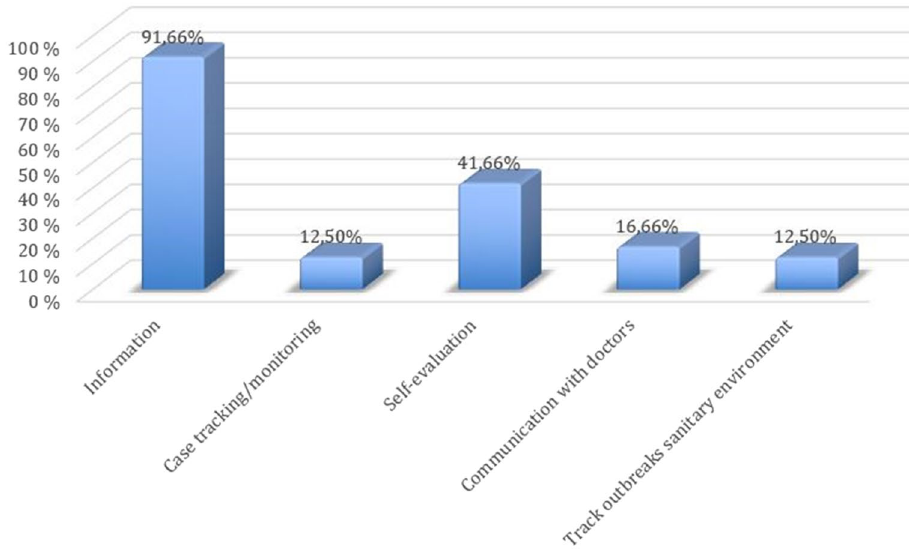
Figure 6. Percentage of apps by